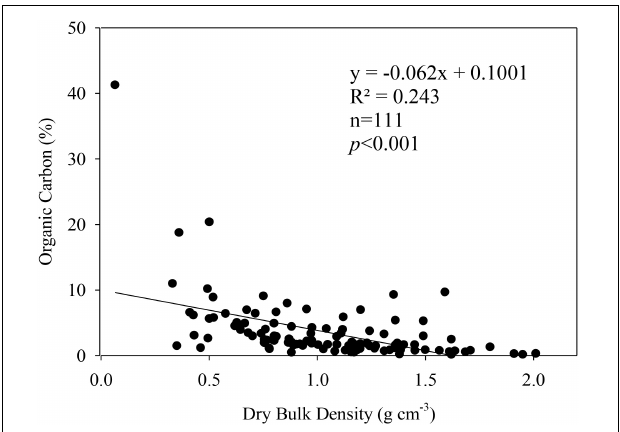
FIGURE 3 | Negative relation between organic carbon content (%) and dry bulk density (g cm − 3 year − 1 ) from the sediment core intervals of this work.